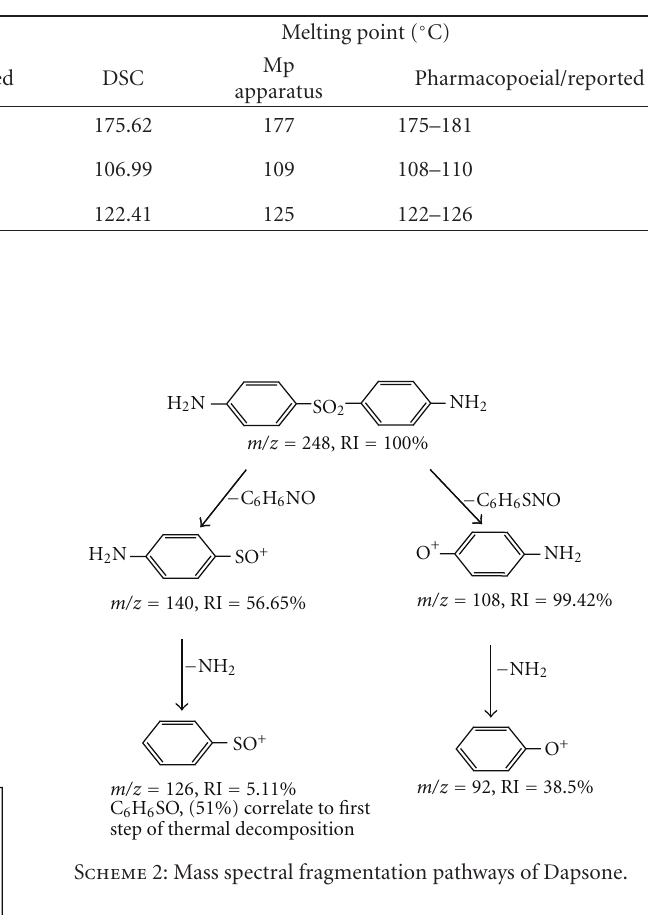
Table 4: Degree of purity and melting point of Dapsone, dimethyl sulfone, and Topiramate in drug substances by DSC, melting point apparatus, and pharmacopoeial and reported methods.